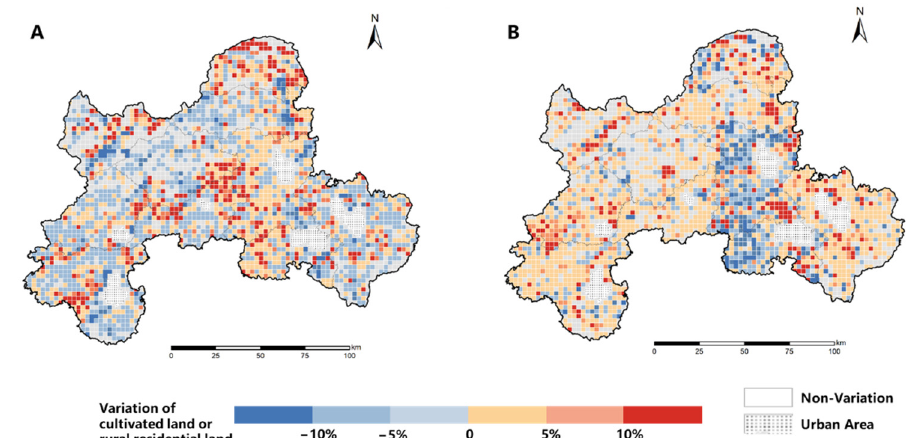
Figure 4. The spatial pattern of variation in cultivated land or rural residential land between 2009 and 2018 (( A ): cultivated land, ( B ): rural residential land). and 2018 (( A ): cultivated land, ( B ): rural residential land). Table 3. The proportion of matching modes distribution between 2009 and 2018.